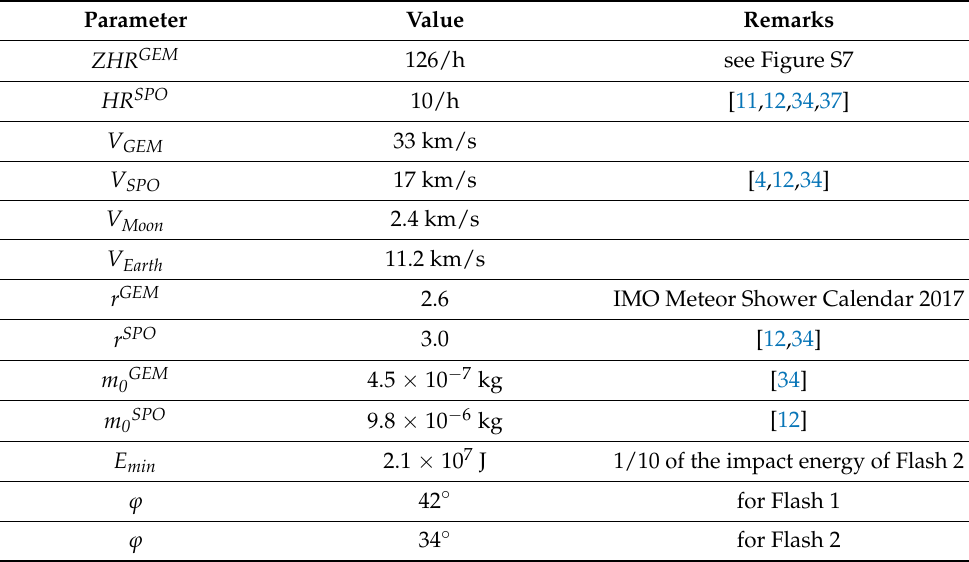
Table 2. Parameters used to calculate the probabilities of a Geminid source of the